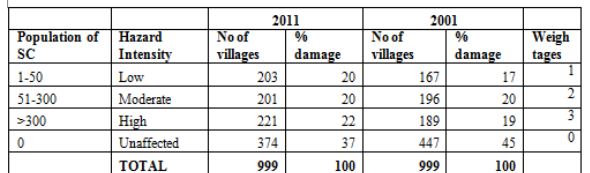
Table 3: Population of SC Vulnerability Index